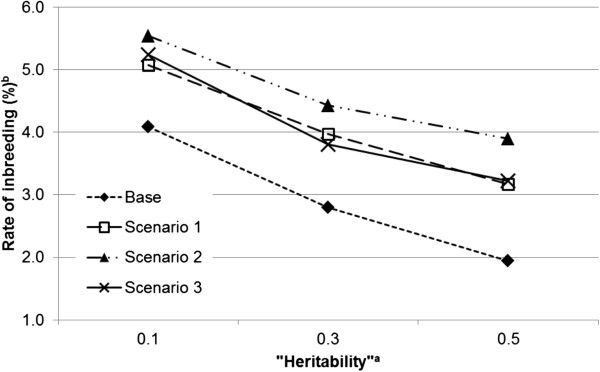
Rates of inbreeding (%) for the four scenarios across heritabilitiesa when correlations between direct and indirect genetic effects are equal to 0. aHeritabilities are the ratio of additive genetic variance to the corresponding “phenotypic” variance; for direct effects hD2=σAD2/σPD2, and for indirect effects hS2=σAS2/σPS2; bthe SE of rate of inbreeding ranged between 0.00039 and 0.00125.